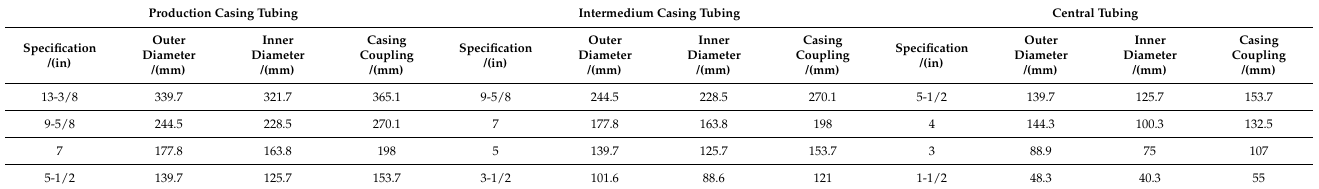
Table 1. Matching table of three-layer tubing–string for commonly used cavern leaching process.